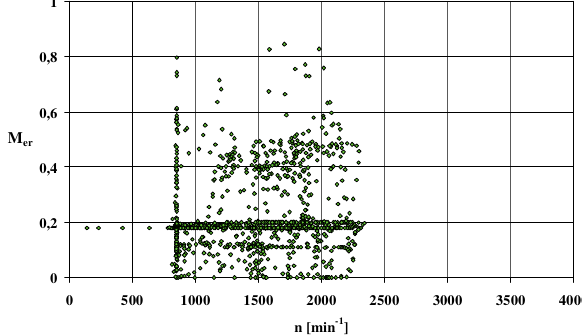
Fig. 12. Mean relative torque value in NEDC, Malta and RDE tests